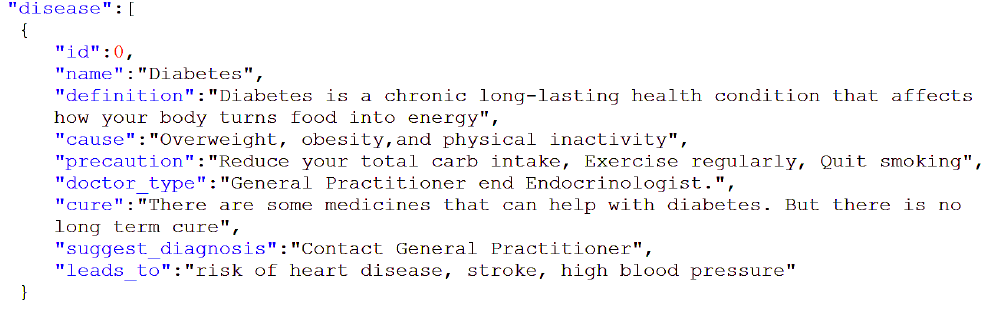
Figure 5. Excerpt from a knowledge base for diseases (which in this case is